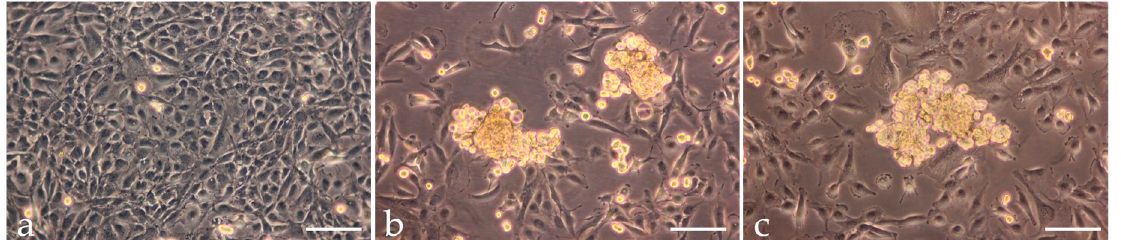
Figure 1. Phase contrast microscopic pictures of UCLA RO82-W-1 1 g -control cells ( a ), and RO82-W-1 cells cultivated on the Random Positioning Machine (RPM) in slides flasks; ( b ) and T25 cell culture flasks; ( c ) for 24 h. Control cells remained adherent and formed a (sub)confluent monolayer ( a ). In both RPM-samples, some cells remained adherent, while others detached forming 3D spheroids of similar size, thus constituting two distinct cell populations ( b , c ). Scale bars = 100 µm.